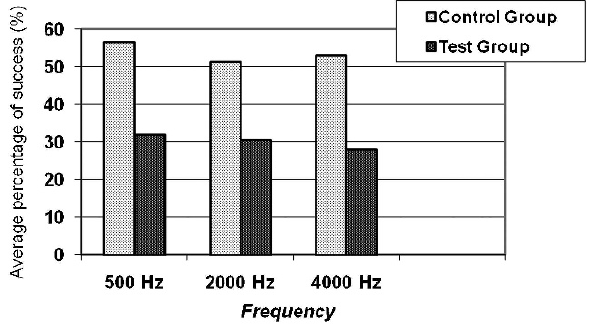
Figure 4 - A comparison of the average percentage of success between the groups according to